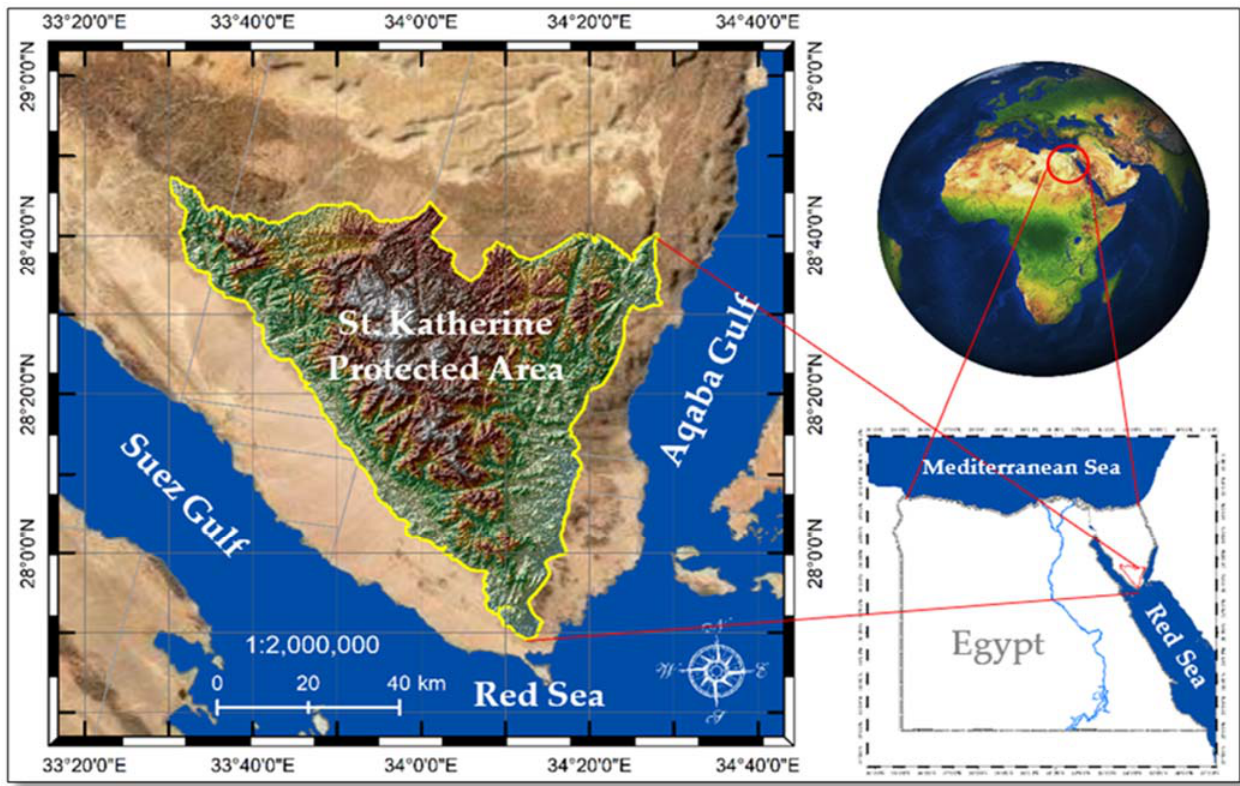
Figure 1. Map of the study area for Saint Katherine protectorate, Sinai Peninsula, Egypt (Base map: acquired using Landsat 8 ‐ 2022 ‐ P/R: 178/39) .